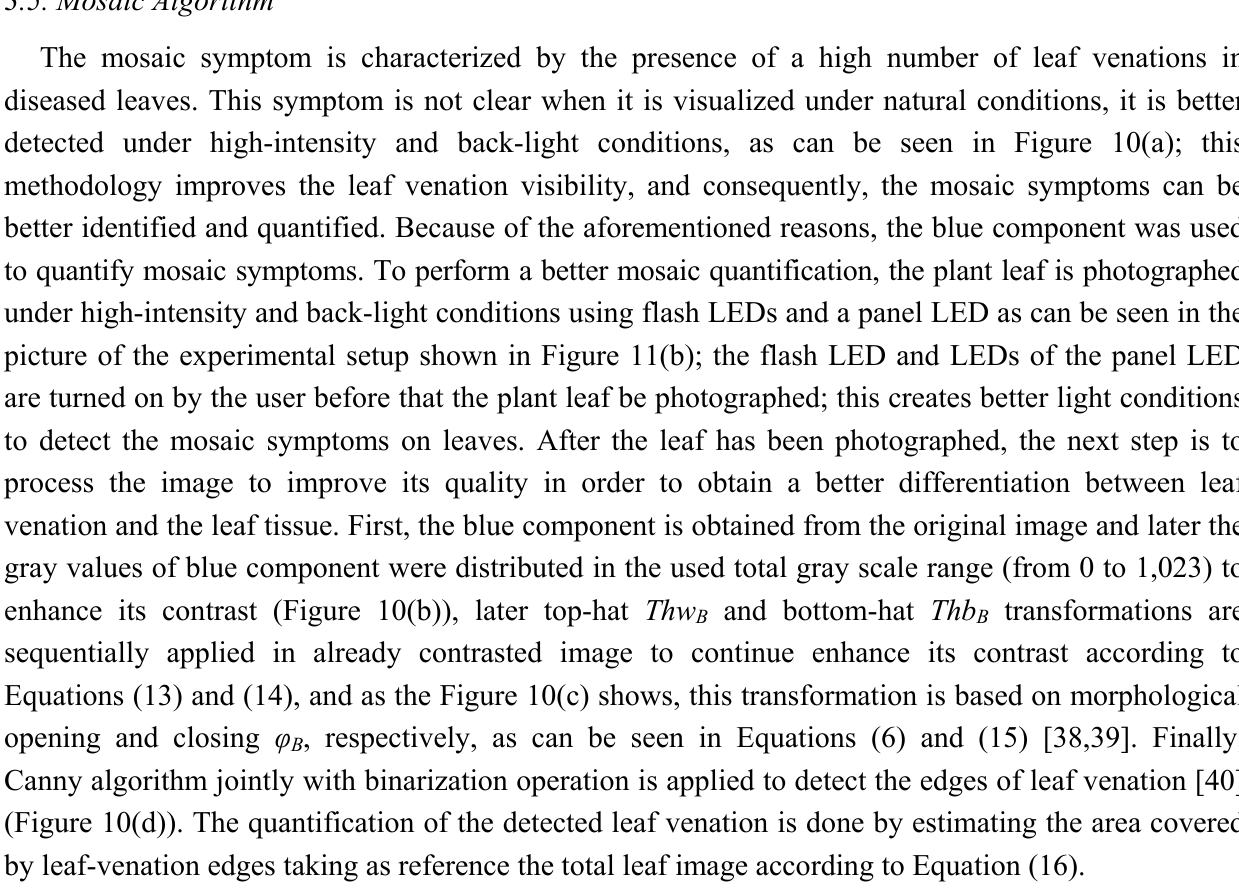
Figure 10. ( a ) Bean leaf in RGB format. ( b ) Blue component of bean leaf with histogram equalization. ( c ) Blue component of bean leaf with contrast enhancement after applying the top-hat and bottom-hat algorithms. ( d ) Identification of bean-leaf